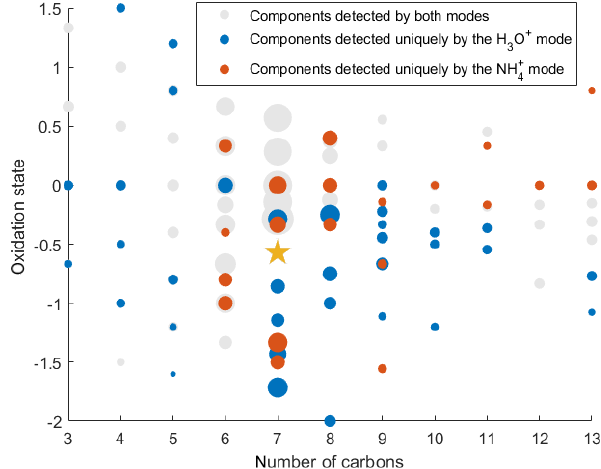
Figure 7. Identified SOA components detected in both H 3 O + and NH + modes (125 peaks), uniquely in the H 3 O + mode (34 peaks), 4 and uniquely in NH + mode (17 peaks) plotted on the n C -OS C dia- 4 gram. The gold star corresponds to the precursor of the photooxida- tion experiment, 3-methylcatechol. The size of the dots is propor- tional to the logarithm of the volume mixing ratio of each compound produced at the end of the